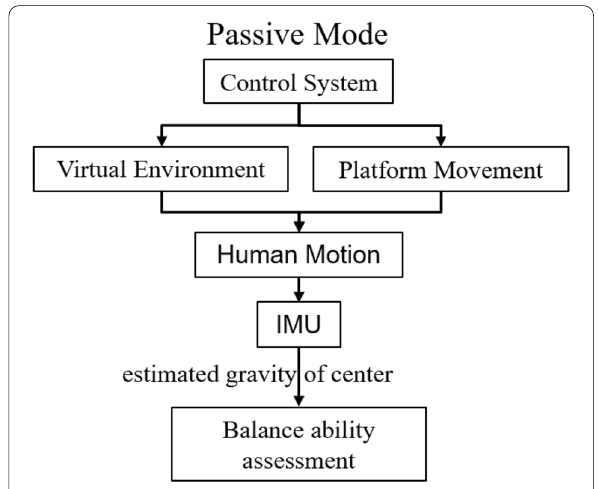
Figure 9 Flow of signals in passive mode